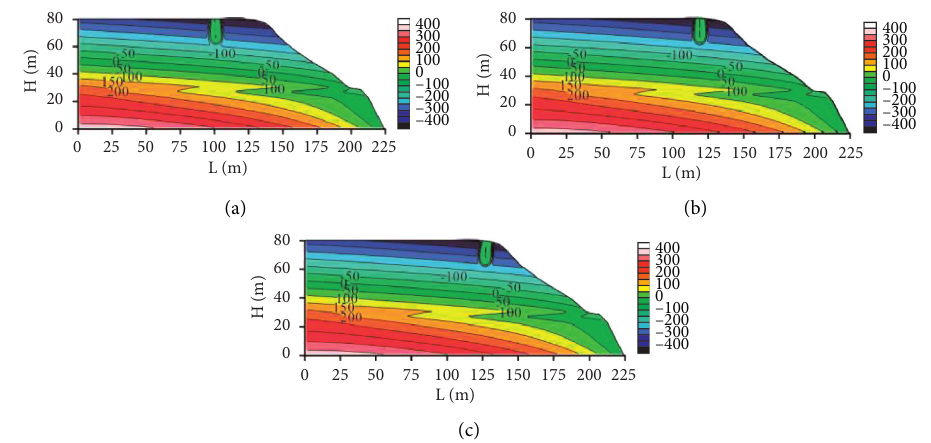
Figure 13: Distribution of pore pressure (kPa) in the slope body at different fissure locations. (a), (b), and (c) The distance between the fracture location and the edge of the pier is 33m, 15m, and 5